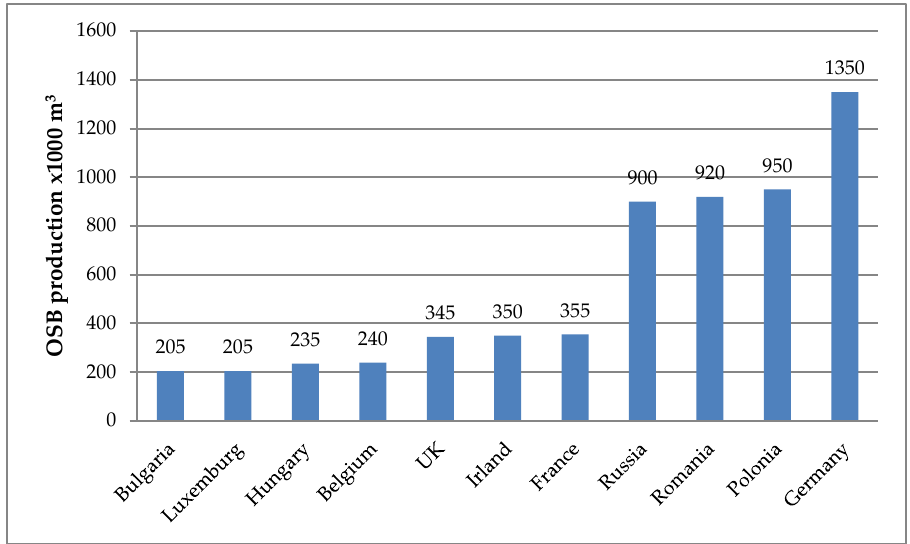
Figure 1. Statistical data compared to the production of oriented strand boards (OSBs).